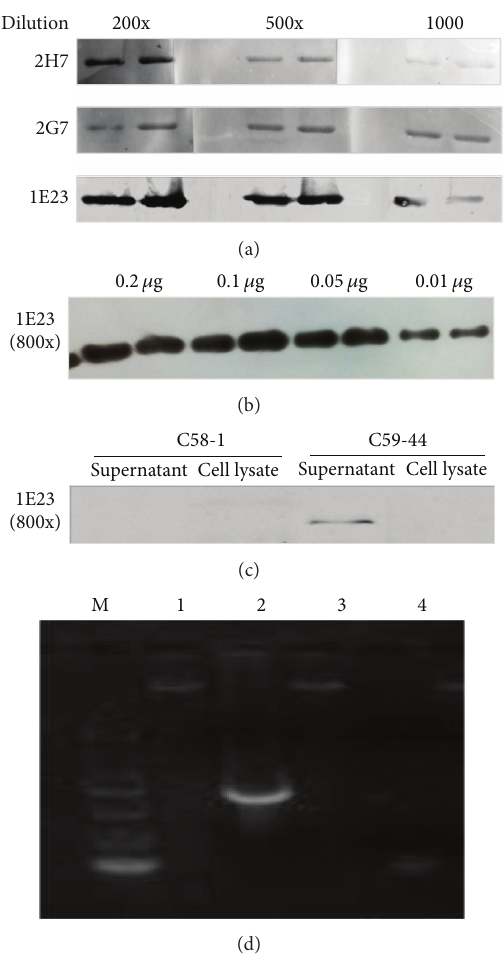
Figure 5: Characterization of monoclonal antibodies to rCPB2 by an immunoblotting assay. Monoclonal antibodies (McAbs) produced by hybridoma cell clones listed in Figure 4(b) were tested for their cross-reactions with rCPB2 and native CPB2 in terms of an immunoblotting assay. (a) Images of immunoblots of monoclonal antibodies produced by 2H7, 2G7, and 1E23 hybridoma cell clones against 0.1 𝜇 g of rCPB2 with indicated dilutions of ascites generated from Balb/C mice. (b) The sensitivity of immunoblotting assay in detection of rCPB2 using McAb 1E23 at a dilution of 800. (c) The sensitivity of immunoblotting assay in detection of native CPB2 in the culture supernatants and cell lysates of C. perfringens type B (C58-1) strain (left panel) and type C (C59-44) strain (right panel) McAb 1E23 at a dilution of 800. (d) A representative image of ethidium bromide (EB) stained agarose gel of genomic DNA and PCR product of cpb2 gene fragment. Lines 1 and 2 were respective C59-44 genomic DNA and PCR fragment of cpb2 genes and lines 3 and 4 were C58-1 genomic DNA and PCR product, respectively. The immunoblotting results showed that McAb 1E23 could react with both recombinant CPB protein and native CPB2 produced by Clostridium perfringens type